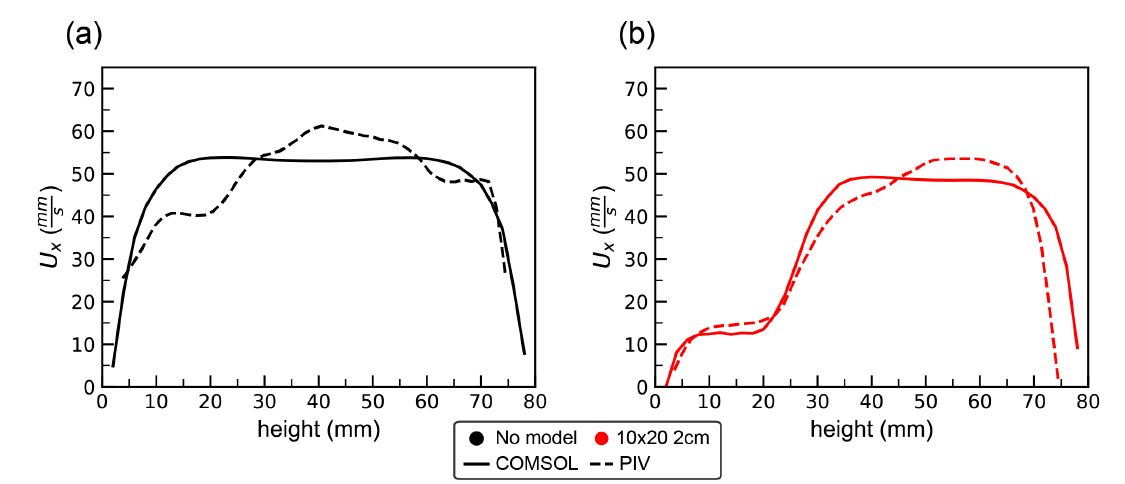
Figure 5. The x -component of the velocity as a function of height taken along a vertical line positioned in the middle of the model for the COMSOL simulation (solid line) and experiment (dashed line): ( a ) the flow profiles with no model; and ( b ) the profiles with the 10 × 20 2-cm